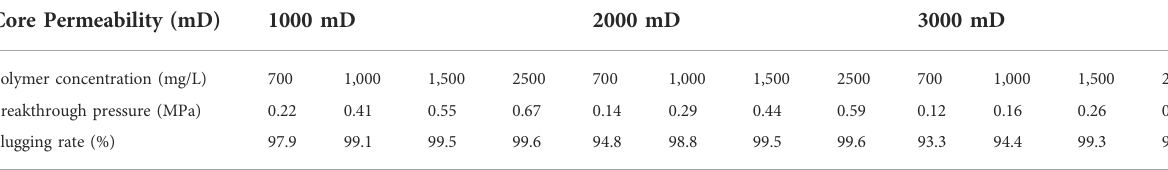
TABLE 4 In-core breakthrough pressure and plugging coef fi cient under different polymer concentrations and core permeability.